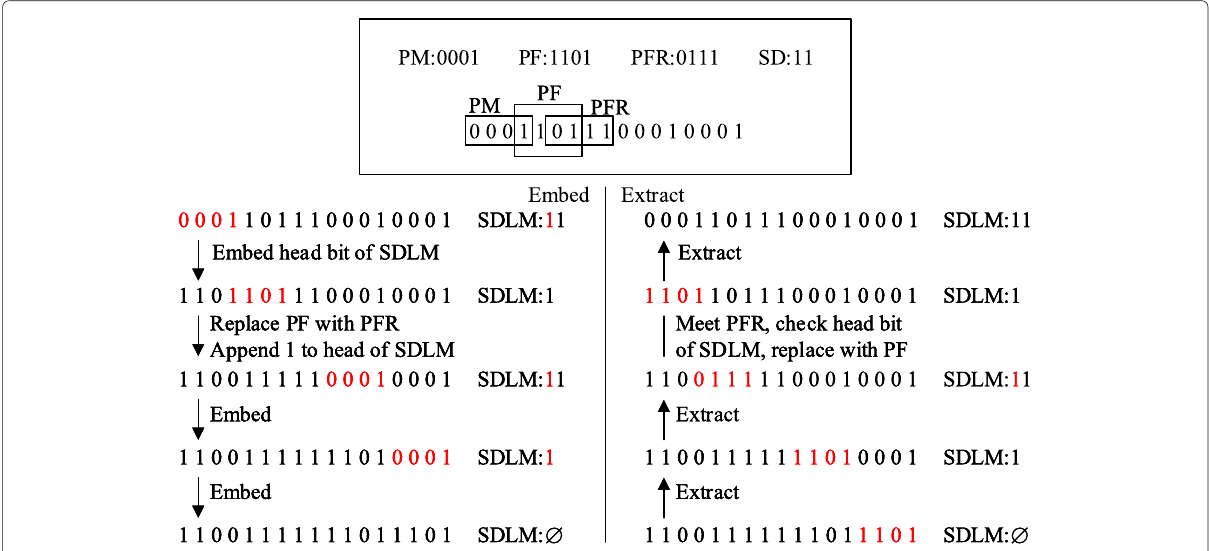
Fig. 9 An example of data hiding with “embedding including LM”